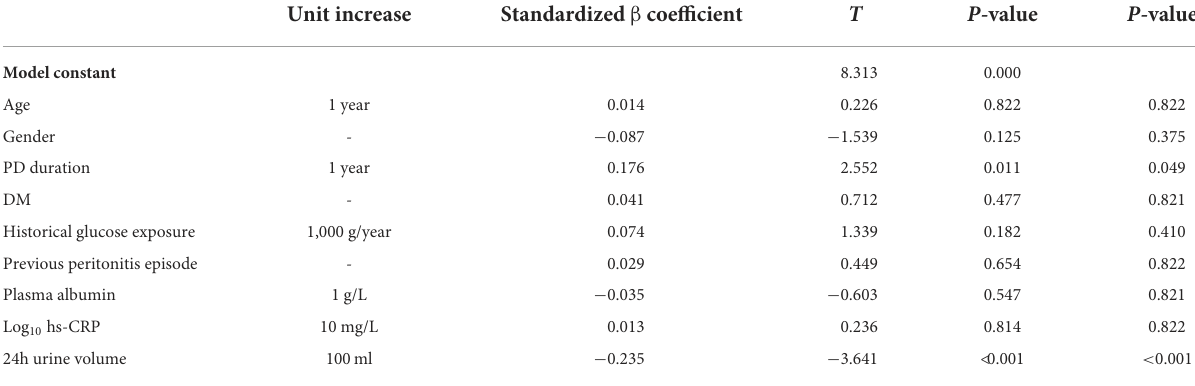
TABLE 3 Association of 24h urine volume with log 10 dialysate IL-6 AR at baseline. Unit increase Standardized β coefficient